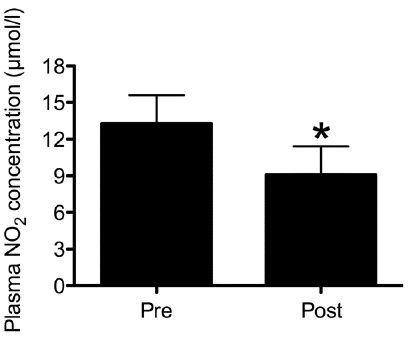
Figure 2. Nitric oxide (NO) concentration before (pre) and after (post) the training program (mean ± SD). *Statistically different compared with pre-values (p # 0.05).